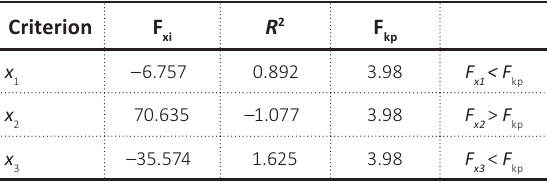
Table 4. Comparison of partial F regression equation